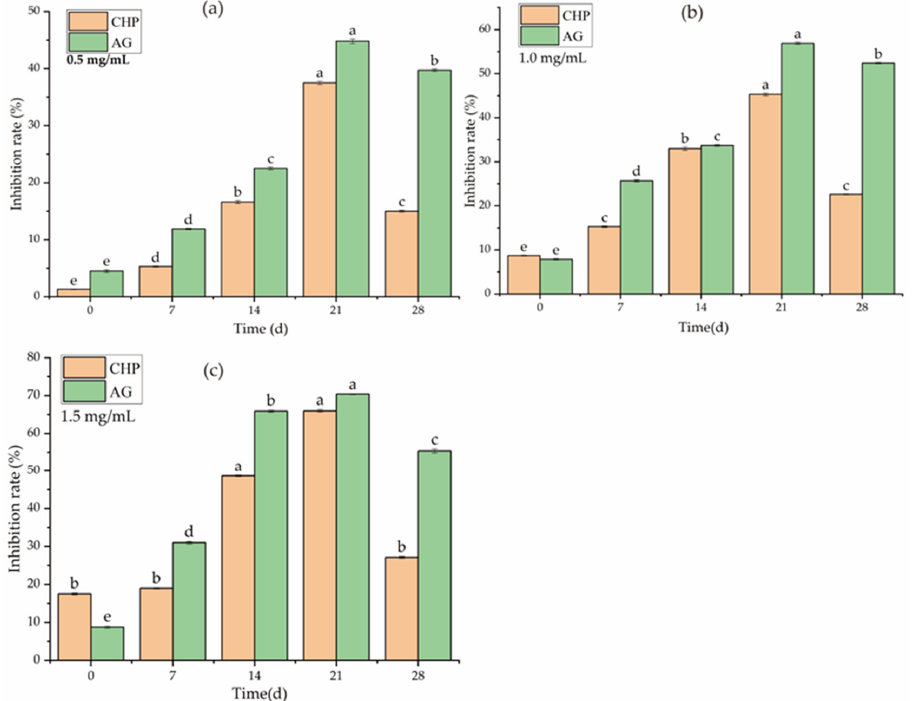
Figure 5. AGE inhibition capacity of CHP; ( a – c ) represent the inhibitory effect of CHP samples at different concentrations (0.5, 1.0, and 1.5 mg/mL) on AGE formation, different letters on the bars represent the significant differences ( p < 0.05).